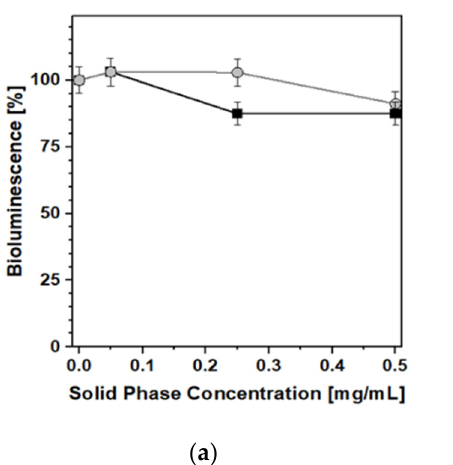
Aliivibrio fischeri F1 ( b ) bioluminescence. 10 min, T = 25 ◦ C.